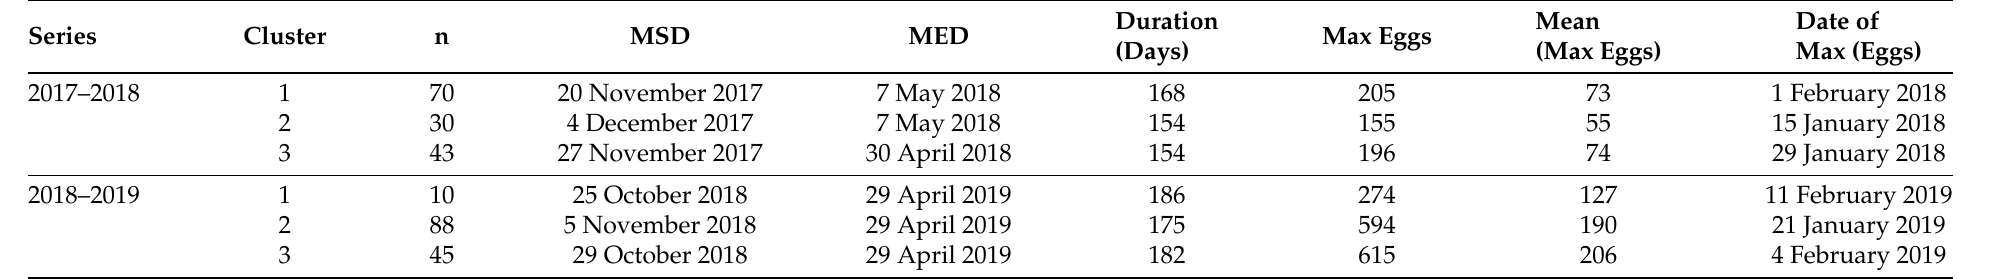
Table 3. Median start and end date of oviposition in the best clustering configurations for 2017–2018 and 2018–2019. References: n, number of time series in each cluster; MSD, median start date; MED, median end